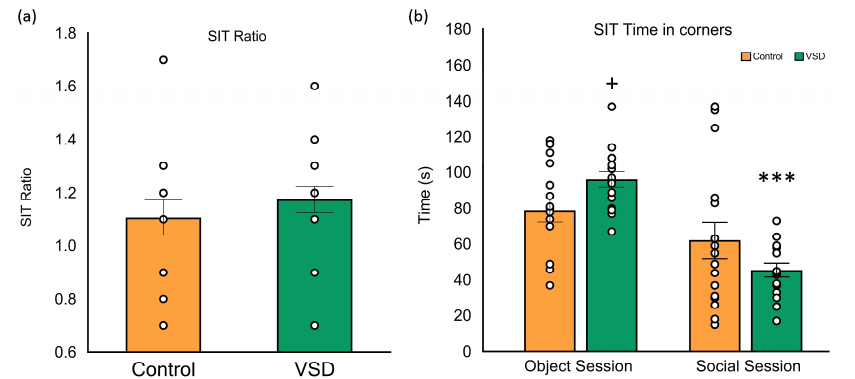
Figure 4. Vicarious Social Defeat VSD did not alter the Social Interaction Test (SIT) ratio in female mice. The bars represent the ratio of the SIT ( a ) and the mean of the time spent in corners during the object and social sessions ( b ), and the vertical lines, ± SEM. Values > 1 indicate preference for social interaction, and < 1 indicates social avoidance. Female mice were divided into control (n = 16) and VSD (n = 16). Interaction stress x sessions: (F (1,30) = 7.123; p < 0.012), Bonferroni post hoc test + p < 0.05, significant difference compared to the control group; *** p < 0.001, significant difference compared to the object